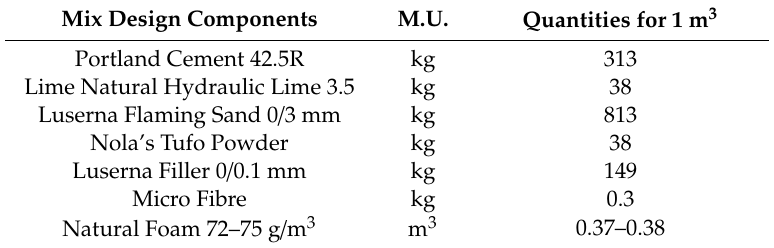
Table 5. Eco-mortar for plaster mix design with the addition of Nola’s Tufo powder.